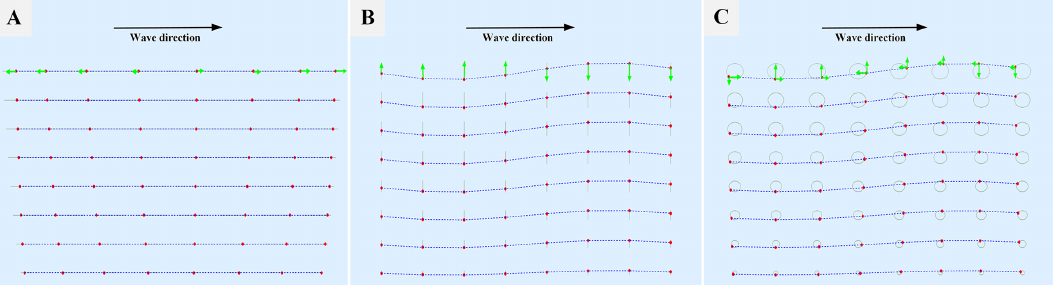
Fig 2. Longitudinal and transverse components of ocean waves. (A)The longitudinal wave. (B) The transverse wave. (C) The ocean wave with longitudinal and transverse components. The red dots indicate the momentary position of fluid particles on their (gray) orbits. The green arrows indicate the directions of motions of particles, and the blue dashed line are isopressure lines. The radius of this circular motion, in (C), is the largest on the ocean surface and this radius exponentially decreases deeper into the water